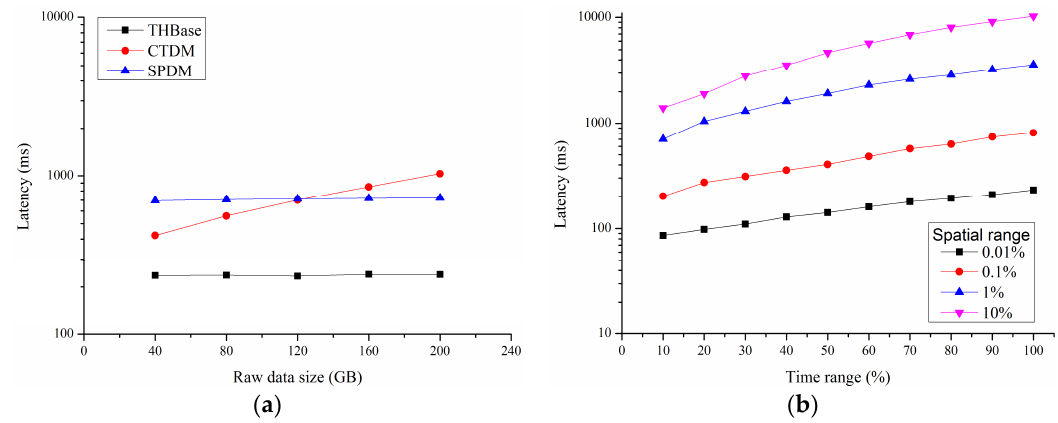
Figure 6. Performance of spatiotemporal range query: ( a ) result of changing data size, ( b ) result of changing spatiotemporal range.